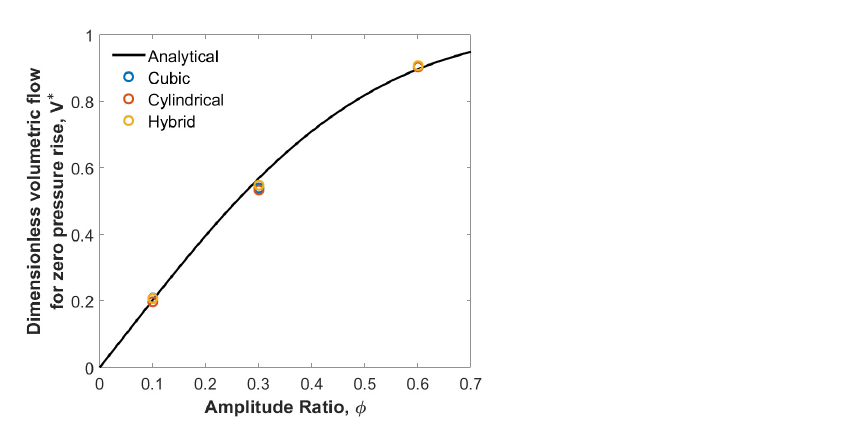
Figure 13. Effect of initial particle arrangement in the SPH model on the dimensionless volumetric flow. 5.1.2. Effect of Kernel Choice The choice of the kernel is important in this study. A comparison between results obtained with different kernels is given in Figure 14. It shows that the results obtained using the quartic kernel give the best match to the analytic solution. The Wendland kernel shows slightly worse agreement, while the cubic kernel performs the worst of these three commonly used SPH kernels. Figure 15 shows the axial velocity contour at 5 s from the SPH models with different kernels. The quartic kernel provides the smoothest and least diffused pattern compared with the Wendland and cubic kernel, with this effect being most obvious in the 𝜙 = 0.1 case, where external forcing is the smallest. Therefore, the